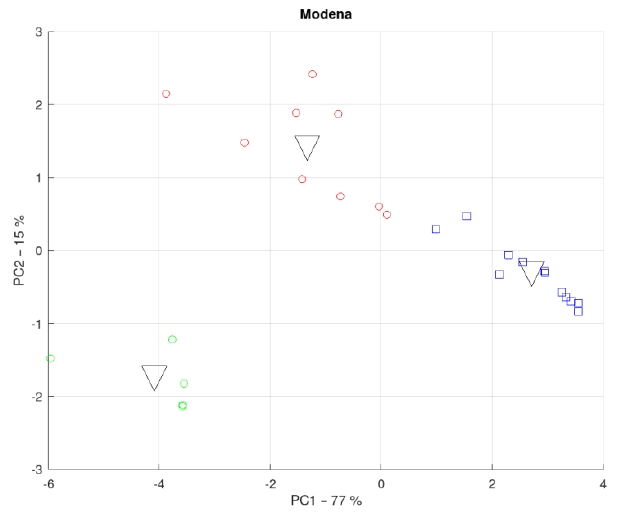
Figure 5. District of Modena 2D-Score plot showing PC1 vs. PC2 with clusters highlighted: first cluster in red and second cluster in blue.